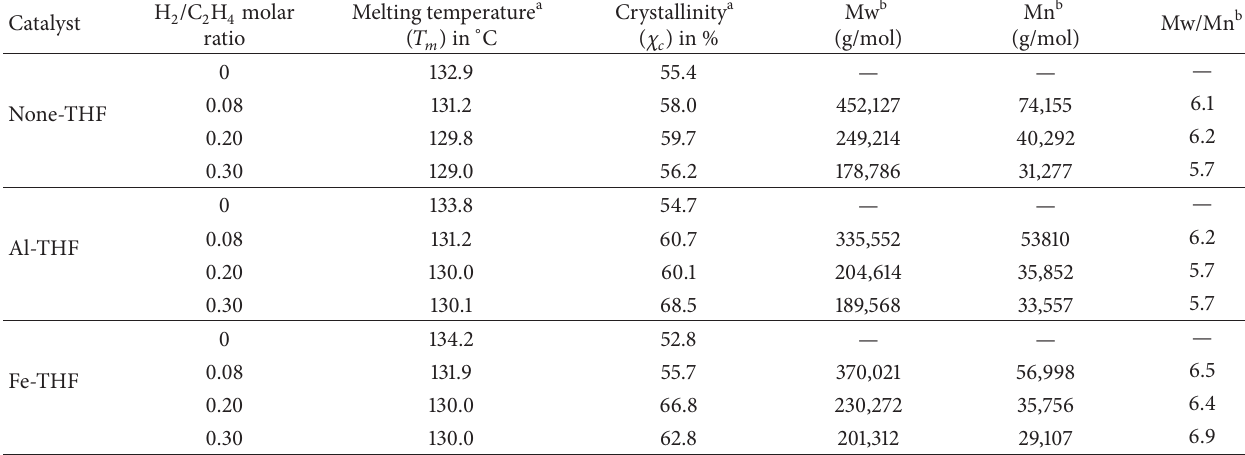
Table 4: Influences of Lewis acids and hydrogen on